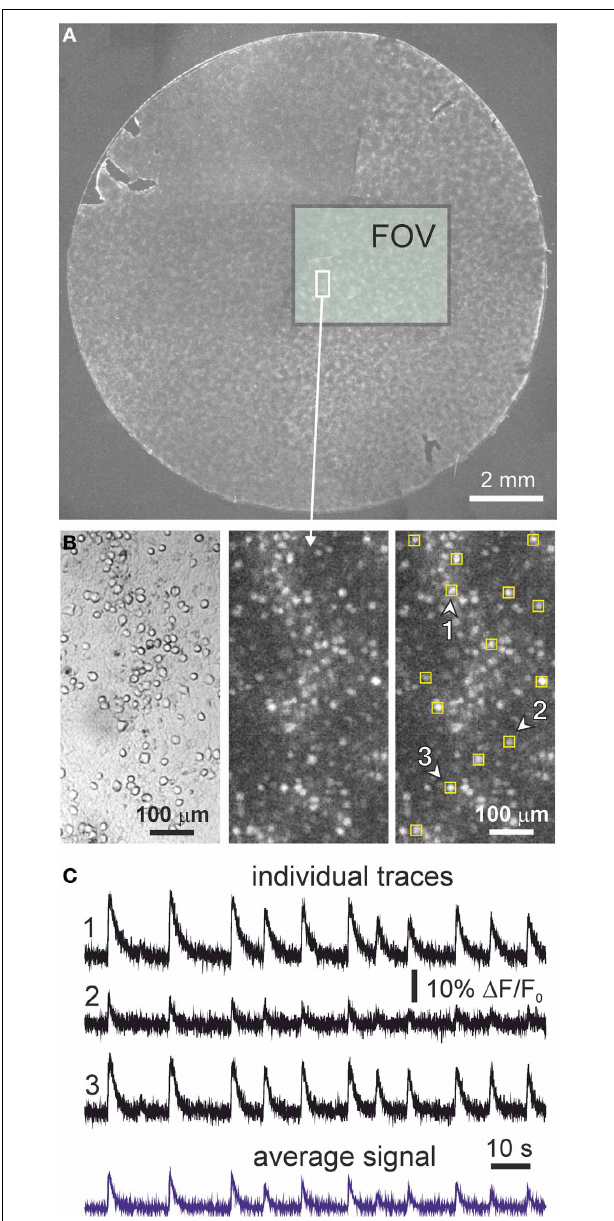
FIGURE 1 | Cortical cultures and neuronal activity. (A) Example of an entire neuronal culture 13mm in diameter at day in vitro 9. The rectangular box shows the actual field of view (FOV) of the camera and illustrates the size of the monitored area. (B) Detail of a small region of the monitored area containing about 100 neurons. Images correspond to bright field (left) and fluorescence (center), together with an example of the selection of the regions of interest for monitoring single neuronal activity (right). The fluorescence image has been integrated over 100 frames, and bright spots correspond to firing neurons. (C) Illustrative fluorescence traces of neuronal activity in three regions of interest (labeled and marked with arrowheads in the above images) along 2min. Fluorescence traces are expressed as (cid:2) F / F 0 (background corrected fluorescence divided by the resting fluorescence). Both excitation and inhibition were active during the recording (“E + I” networks). Note the variability in fluorescence amplitude from neuron to neuron. The bottom trace in blue shows the fluorescence signal averaged over all the neurons in the field of